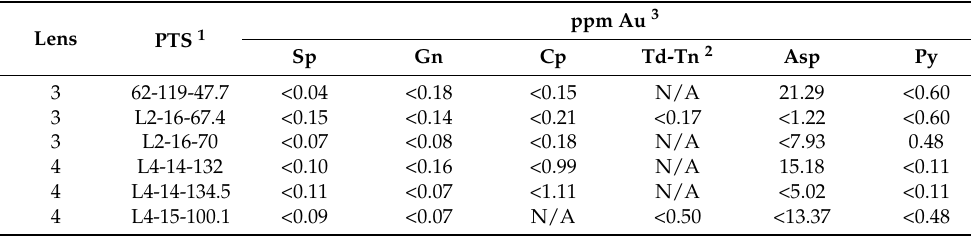
Table 6. LA-ICP-MS Au average grain concentrations.